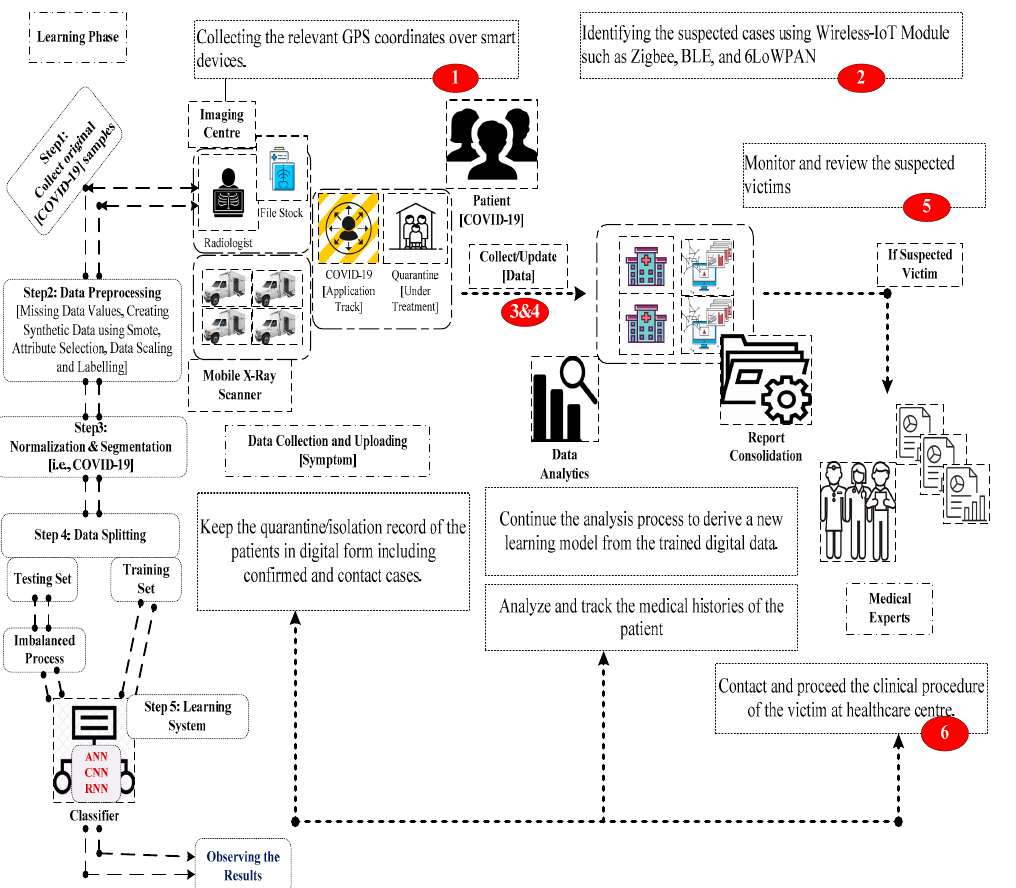
Figure 2. Systematic workflow of intelligent Edge-IoT model.